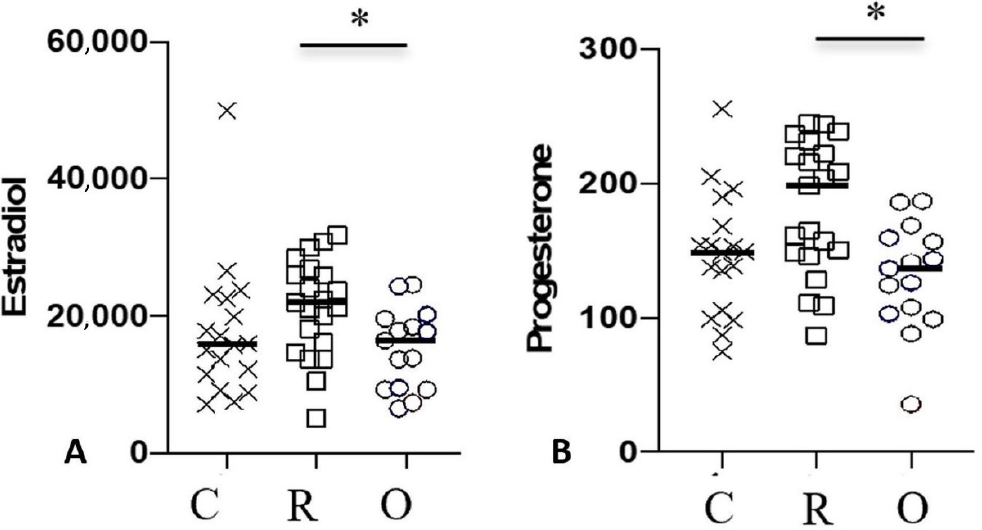
Figure 4. Concentrations of estradiol (pg/mL) and progesterone (ng/mL) in mothers. Data are shown for healthy controls (n = 18; C: crosses), recovered patients (n = 21; R: open squares) and patients with ongoing infection (n = 16; O: circles). Black lines represent the median. * p < 0.05.